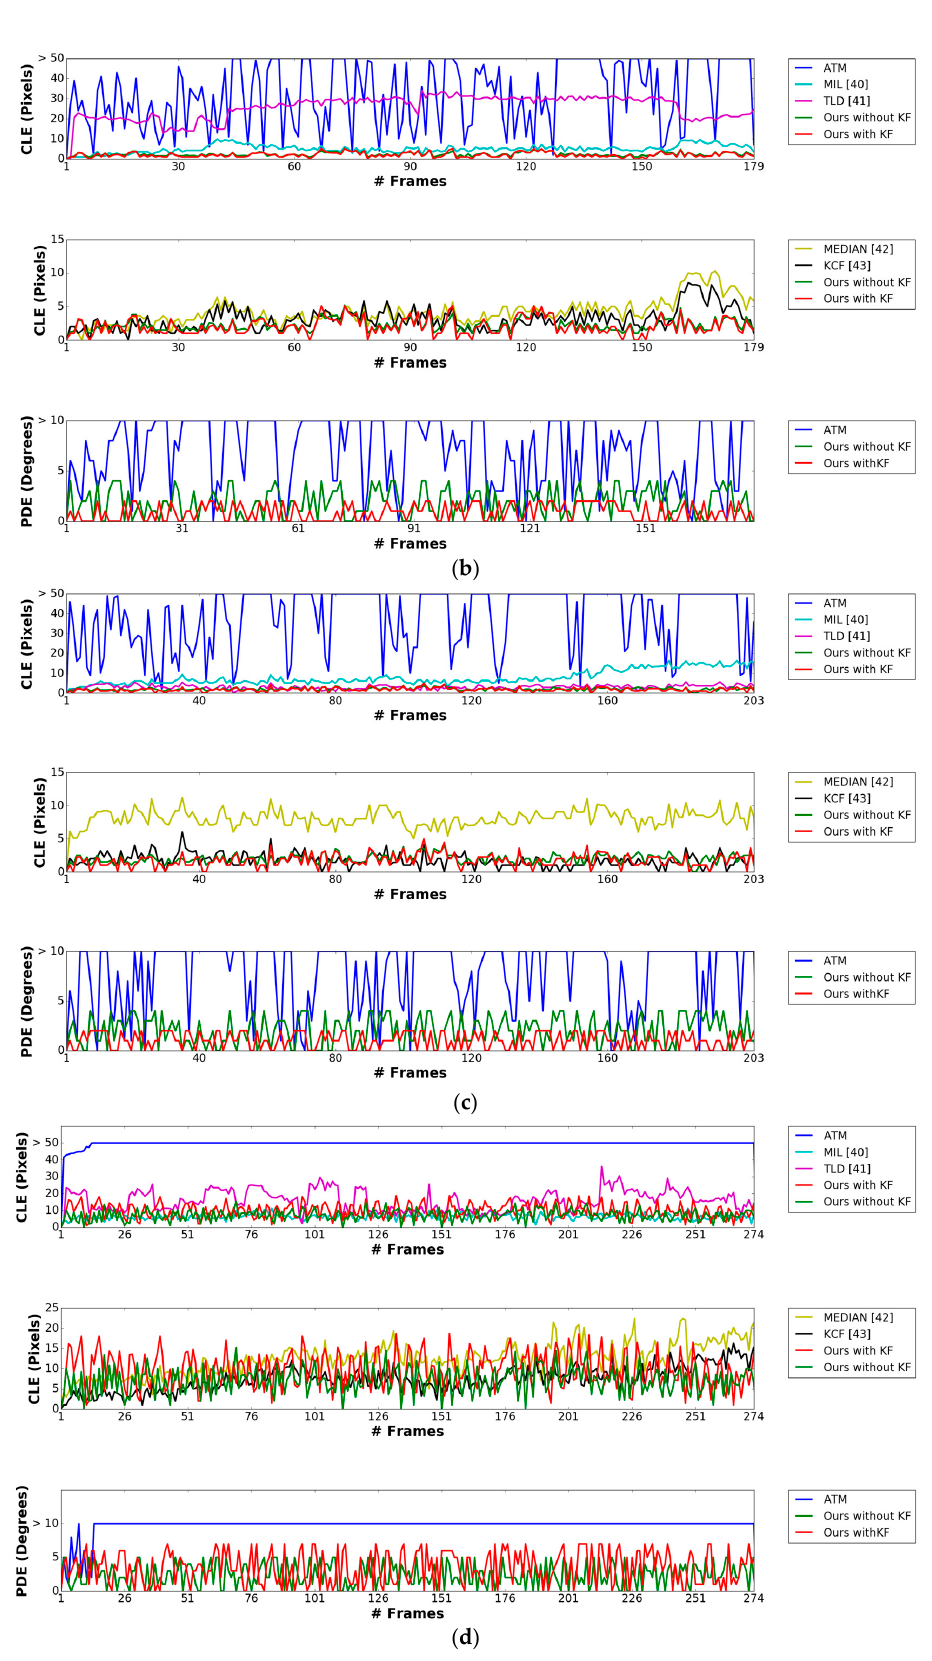
Figure 13. Comparisons of CLE and PDE obtained by our method with those obtained by other methods using sub-database 2 including the videos captured ( a ) in the morning, ( b ) in the afternoon, ( c ) in the evening, and ( d ) at